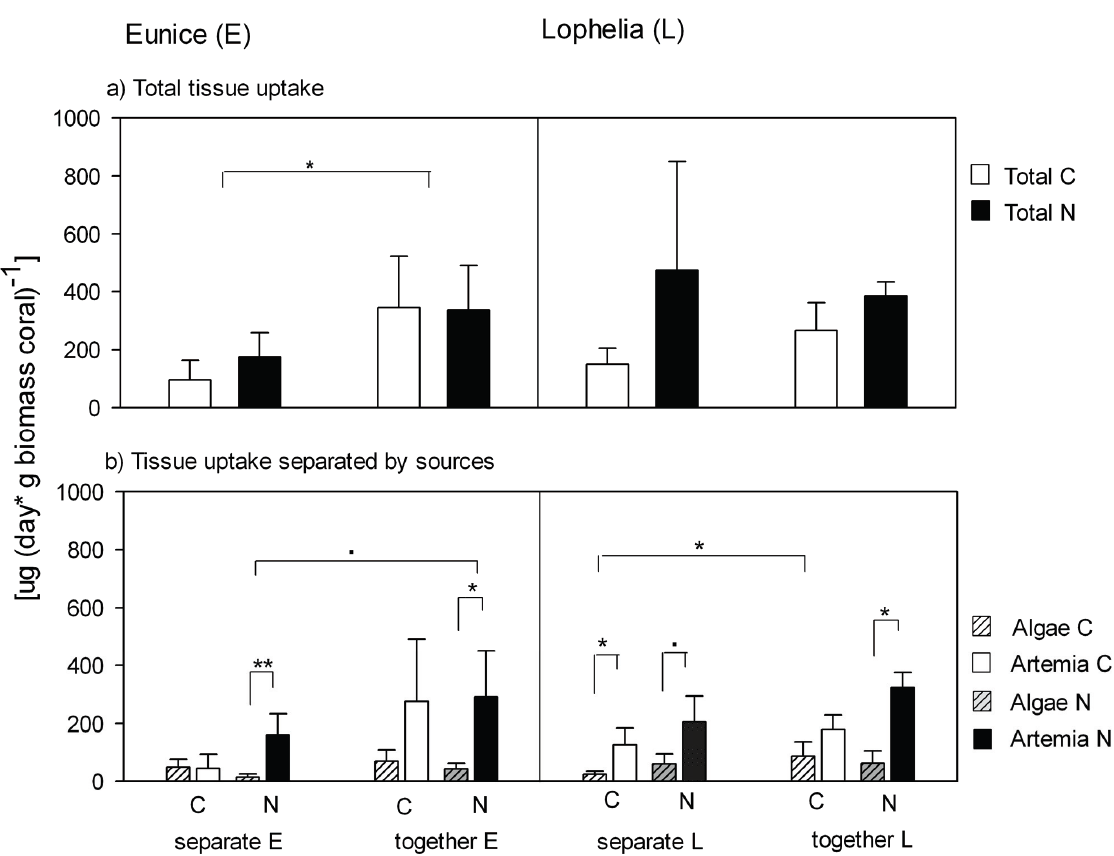
Figure 2. Tissue uptake by E.norvegica (E) and L.pertusa (L.). a) Total tracer C and tracer N tissue uptake, b) Tracer C and tracer N tissue uptake separated by food substrate (algae, Artemia ). Animals were incubated separate or together in one chamber; statistical significance between treatments is indicated as followed: **p , 0.009, *p , 0.05, ? 0.05 , p , 0.06. The bars in each figure represent average 6 SD.